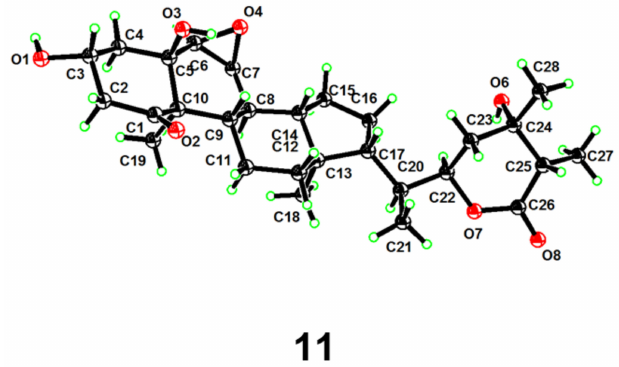
Figure 9. Perspective ORTEP drawings for compound 11